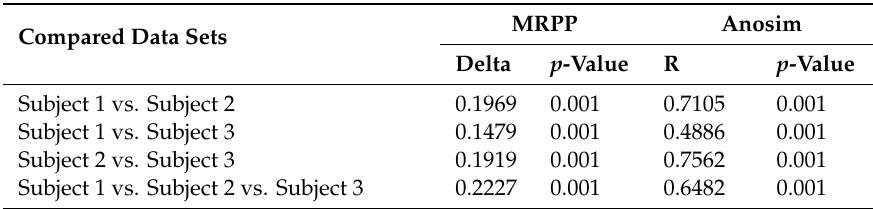
Table 3. Summary of multiple response permutation procedure (MRPP) and analysis of similarity (Anosim) tests between each